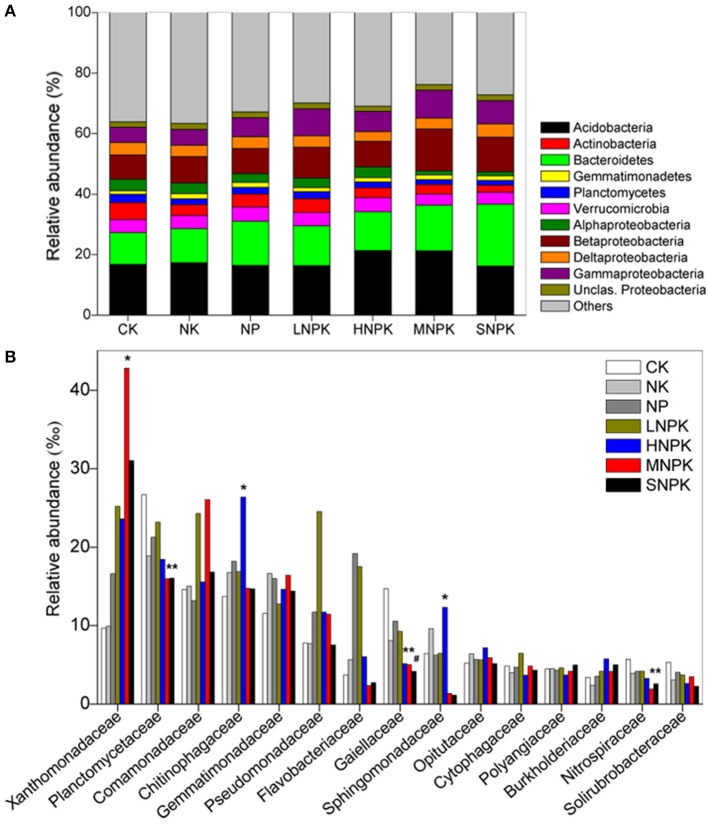
Stacked and unstacked histograms showing the relative abundance of (A) major bacterial phyla and dominant classes of Proteobacteria and (B) 15 most abundant bacterial families, respectively, in treatments CK (unfertilized control), NK, NP, LNPK (low rate of N, regular PK), HNPK (high rate of N, regular PK), MNPK (manure plus NPK) and SNPK (straw plus NPK). Each stripe represents the mean of three replicates. * and # mark significant differences at P < 0.05 and 0.01, respectively.